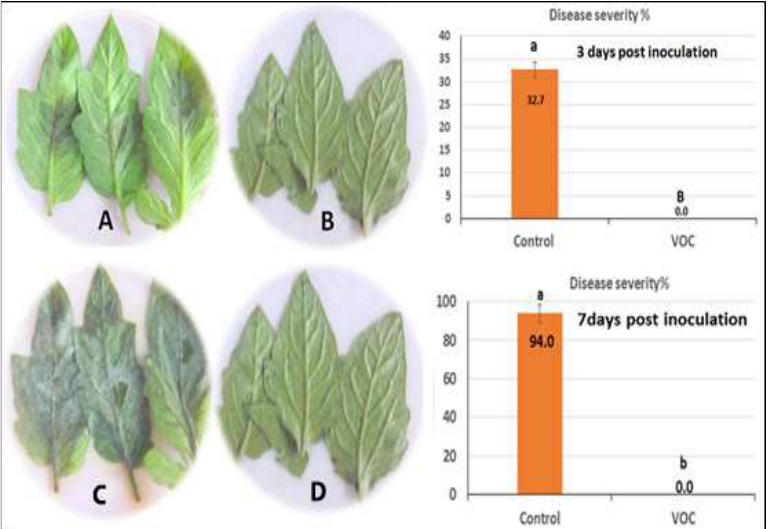
Figure 6. Efficacy of VOCs on tomato late blight using detached leaflet assay. ( A ) Positive control; ( B ) suppression of P. infestans of tomato leaves where there is no infection or any symptoms on susceptible variety; ( C ) Positive control of late blight disease seven days post-inoculation; ( D ) disease severity percentage of late blight seven days post-inoculation where there is no infection of P. infestans . Values in the same bar chart followed by different letters are significantly different at p < 0.05.